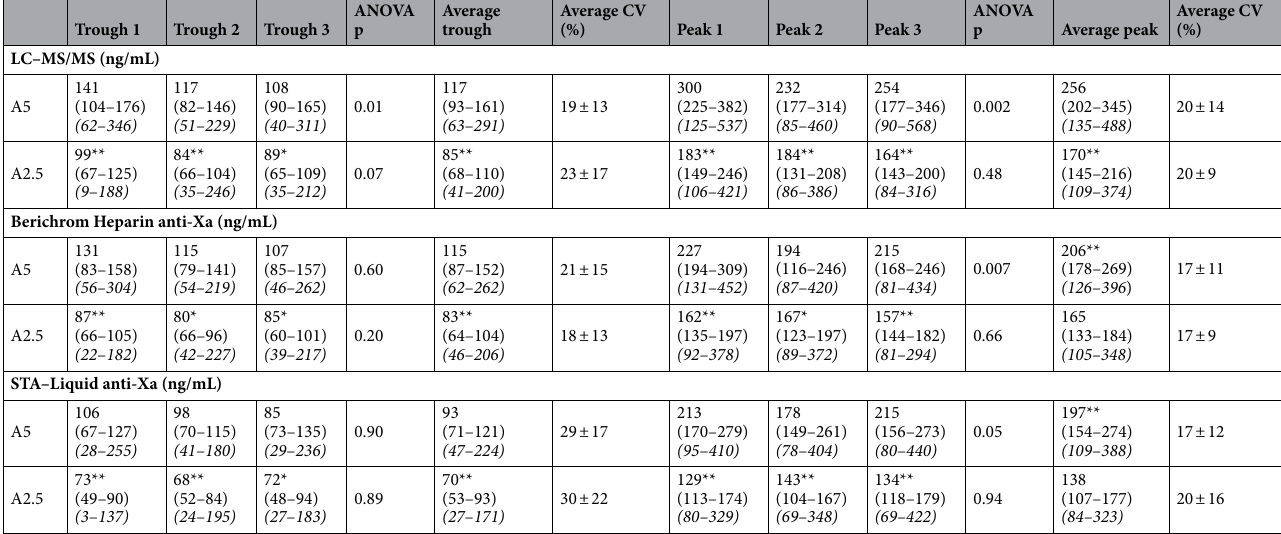
Without bleeding With bleeding (N = 21) (N = 41) p With TE (N = 4) Without TE (N = 58)